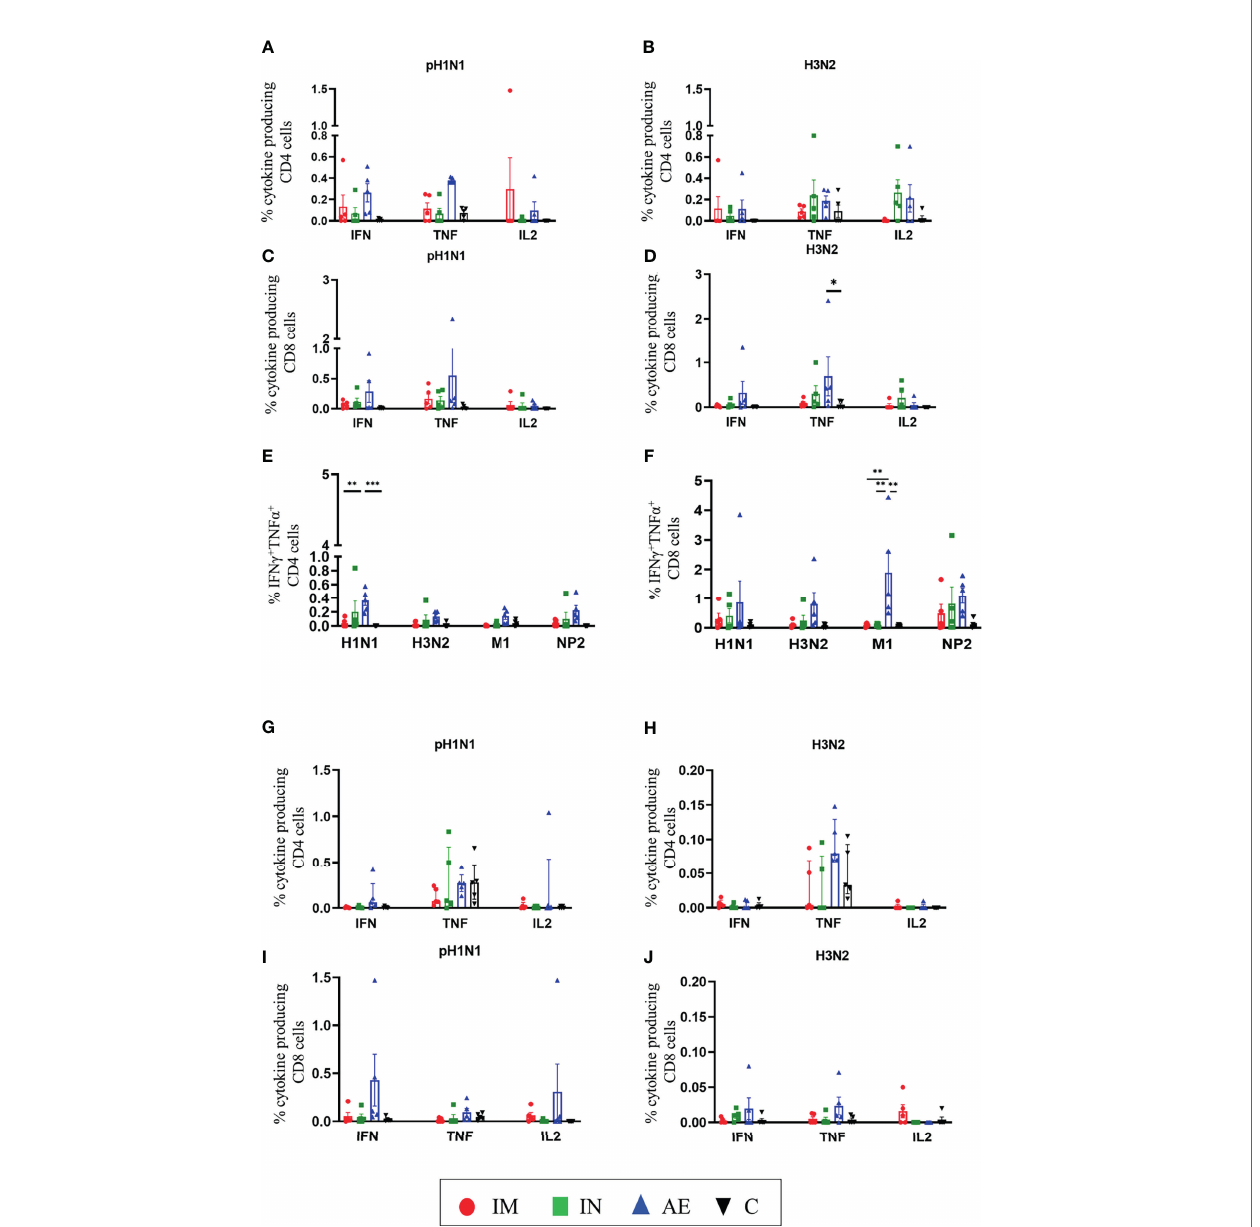
FIGURE 5 | T-cell cytokine responses in BAL and TBLN. (A – F) BAL and (G – J) TBLN were collected 4 weeks post-immunization. Cryopreserved cells were thawed and stimulated with (A, C, G, I) pH1N1 or (B, D, H, J) H3N2, and IFN g , IL-2, TNF, and IFN g TNF cytokine secretions were measured in CD4 and CD8 T cells by intracellular cytokine staining. IFN g TNF co-production within (E) CD4 and (F) CD8 T cells in BAL was determined following pH1N1, H3N2, or M1 and NP2 protein stimulation. Each symbol represents an individual animal. For graphs (G) and (H) , Kruskal – Wallis and Dunn ’ s multiple comparisons tests were performed, and the top of these bars indicates the median and the line the interquartile range. The rest of the graphs were analyzed by two-way ANOVA and Bonferroni ’ s multiple comparisons test, and the top of these bars indicates the mean and the line the standard error (SEM). Asterisks indicate signi fi cant differences (* p < 0.05, ** p < 0.01, *** p <